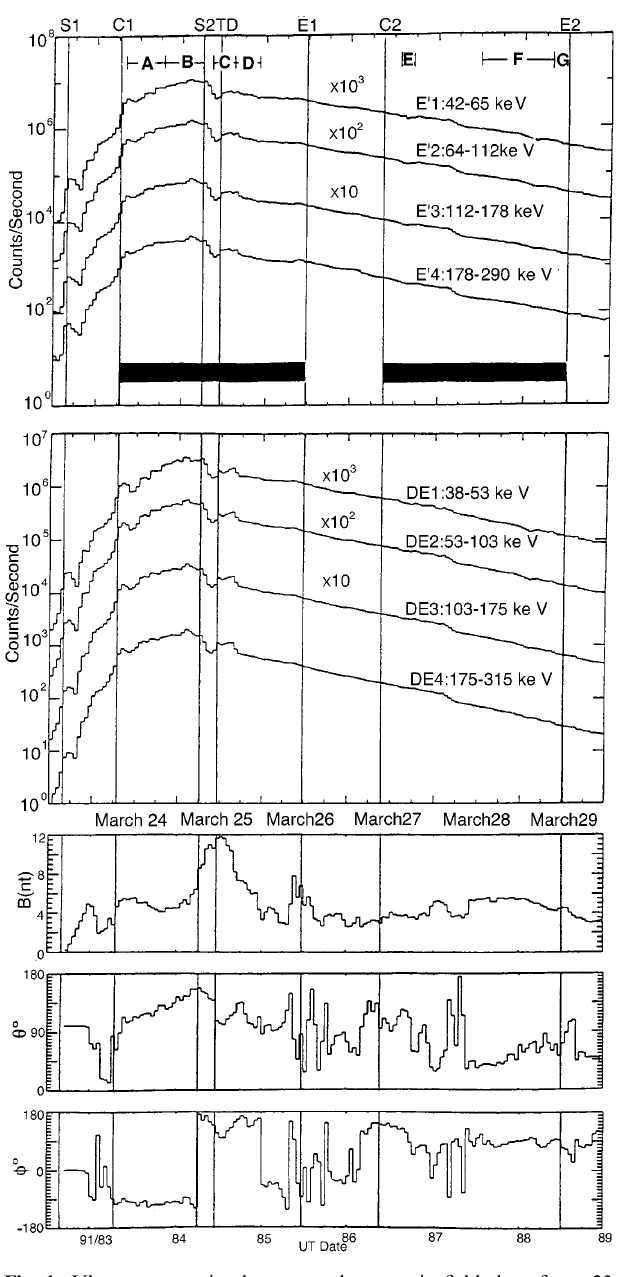
Fig. 1. Ulysses energetic electron and magnetic field data from 23 12:00 UT–29 March 1991 (days 82 12:00 UT – 88). Top to bottom : 42– 290 keV hourly and spin-averaged electron counting rates, as measured by the sunward looking LEFS60 telescope, 38–315 keV hourly and spin-averaged counting rates of magnetically deflected electrons measured by the WART B detector, IMF magnitude, latitude h , and azimuth angle / of the magnetic field vector, as measured by the VHM/FGM magnetometer in RTN local helio- spheric coordinates. Shaded bars show the two ICME intervals. Vertical traces S1 , S2 , C1 , C2 , E1 , E2 and TD mark the two shocks, the commencement and end of the two ICMEs and the tangential discontinuity observed within the first ICME. Also depicted are the extended regimes ( A–G ) observed during the passage of the ICMEs over Ulysses that exhibited distinctly di(cid:128)erent and unusual electron